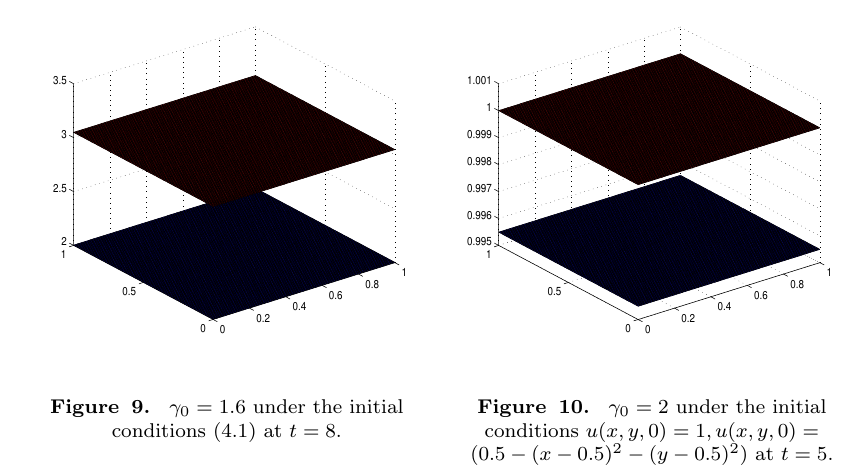
Figure 7. γ 0 = 2, the structure of density u ( x,t ) is shown at t = 0 . 01.